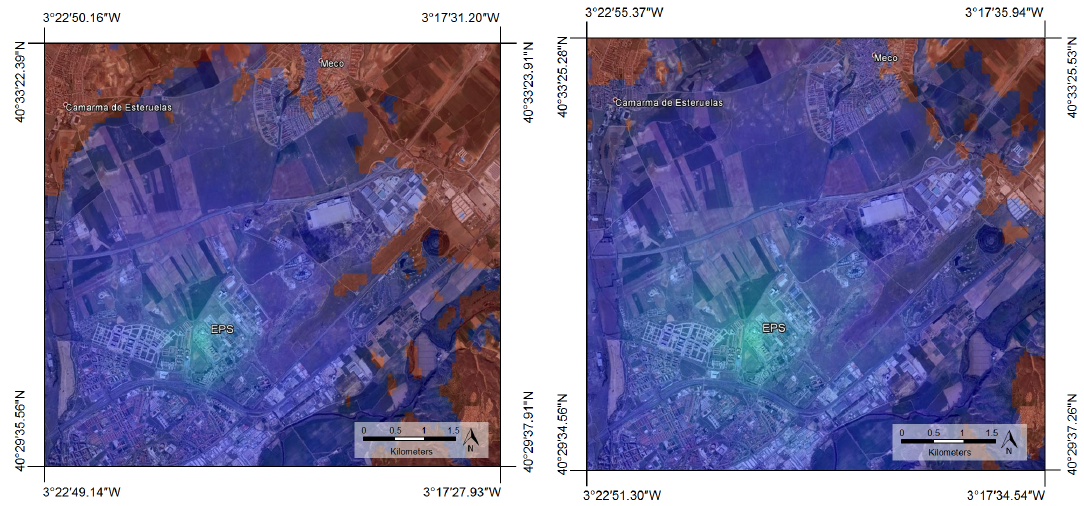
Figure 18. IDEPAR range coverage in the considered radar scenario. ( a ) Only one Televés 4G NOVA antenna in the surveillance channel; ( b ) Televés 4G NOVA antenna array in the surveillance channel.